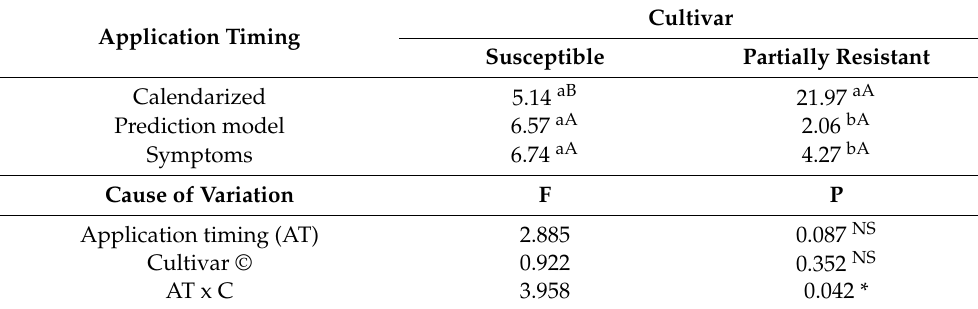
Table 3. Mean percentage coverage (%) on water-sensitive papers in the first application of Field 2, according to different application timings and soybean cultivars in each canopy region.